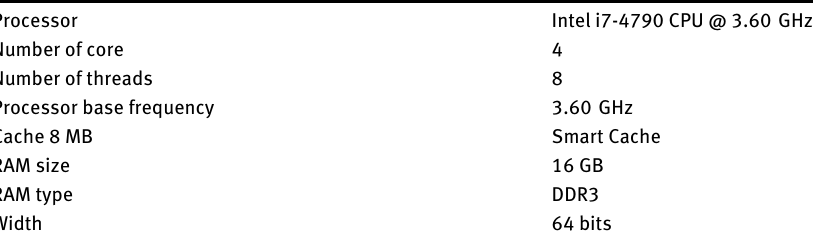
Table 3: System Specification.